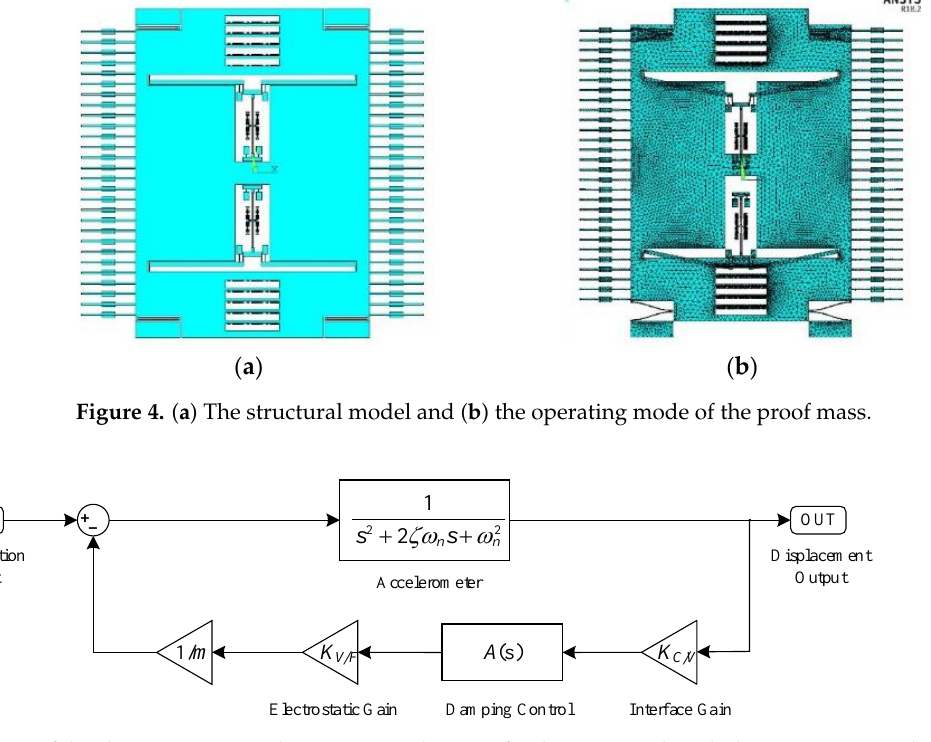
Figure 4. ( a ) The structural model and ( b ) the operating mode of the proof mass.